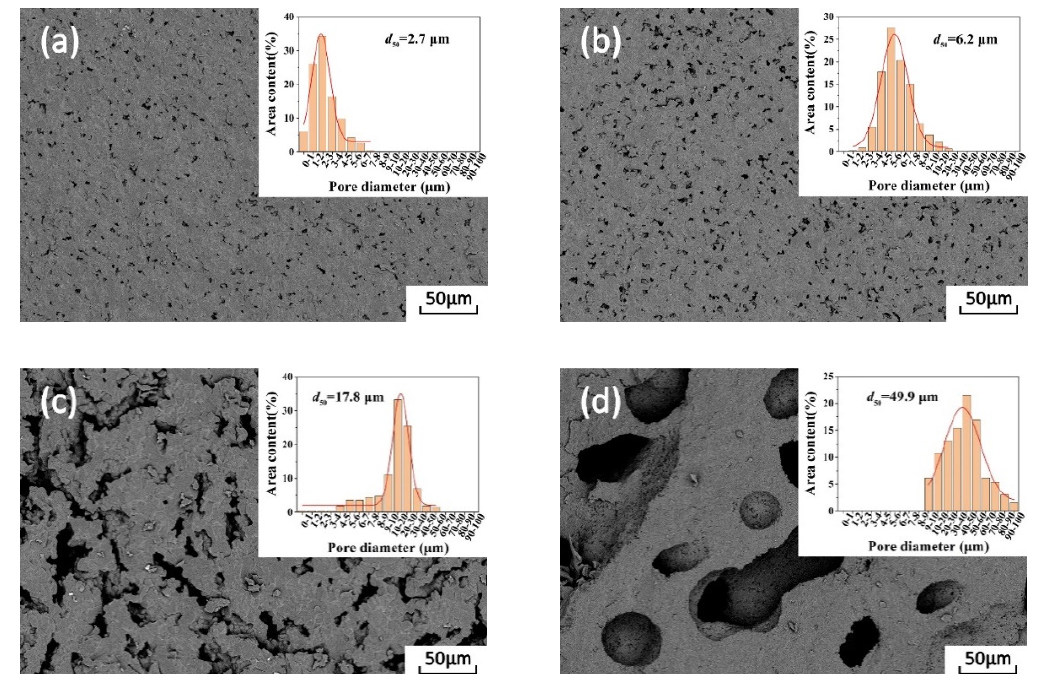
Figure 5. SEM images of porous Al 2 O 3 ceramic membrane prepared by adding PS with different specifications: ( a ) PS10, ( b ) PS30, ( c ) PS50 and ( d ) PS100. The insets in ( a – d ) show the corresponding pore size distribution.